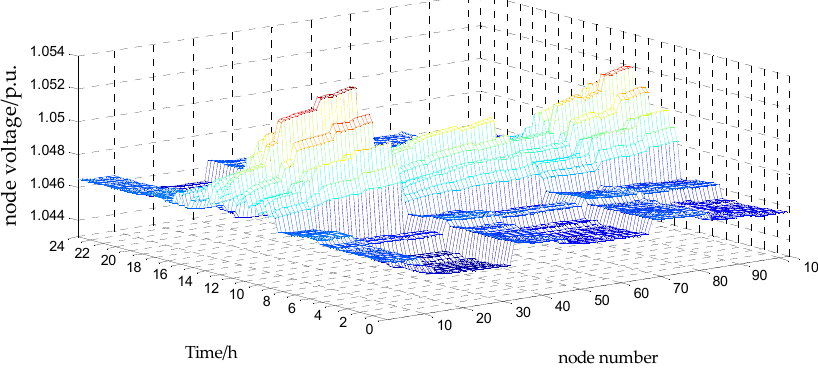
Figure 7. Voltage profiles without any voltage regulation in one day.